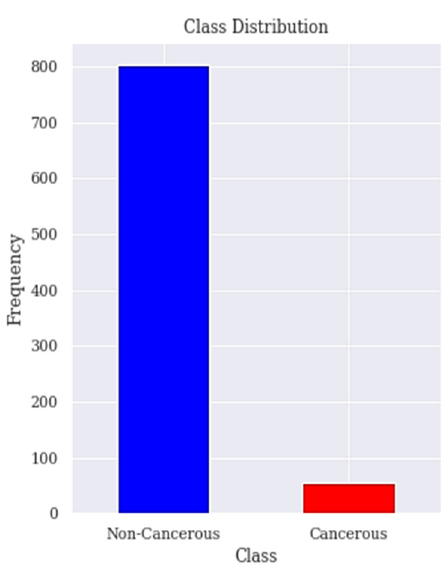
Figure 1. Class distribution. The class distribution of people with and without cervical cancer in the dataset is shown here.